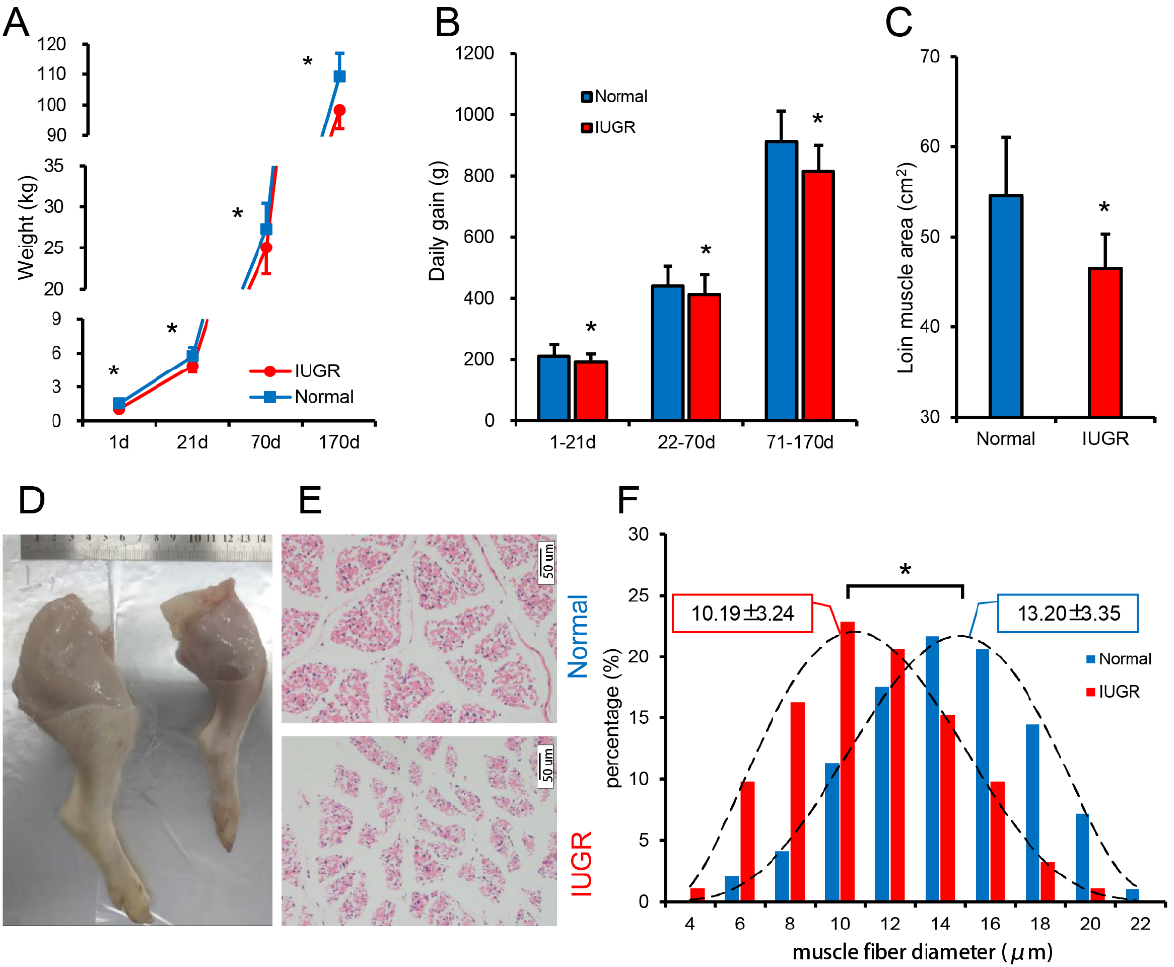
Figure 1. IUGR pigs with skeletal muscle dysplasia. ( A ) Birth to adult weight of normal and IUGR pigs; ( B ) Daily weight gain of normal and IUGR pigs at different stages; ( C ) Loin muscle area of 170–day–old normal and IUGR pigs, measurement using B-mode ultrasound; ( D ) Photographs of the legs of newborn normal and IUGR pigs; ( E , F ) HE (Hematoxylin and eosin) staining of longissimus dorsi muscle and muscle fiber diameter analysis. ( A – C ): Normal group, N = 149; IUGR group, N = 75; ( D – F ): N = 3. * p –value ≤ 0.05.